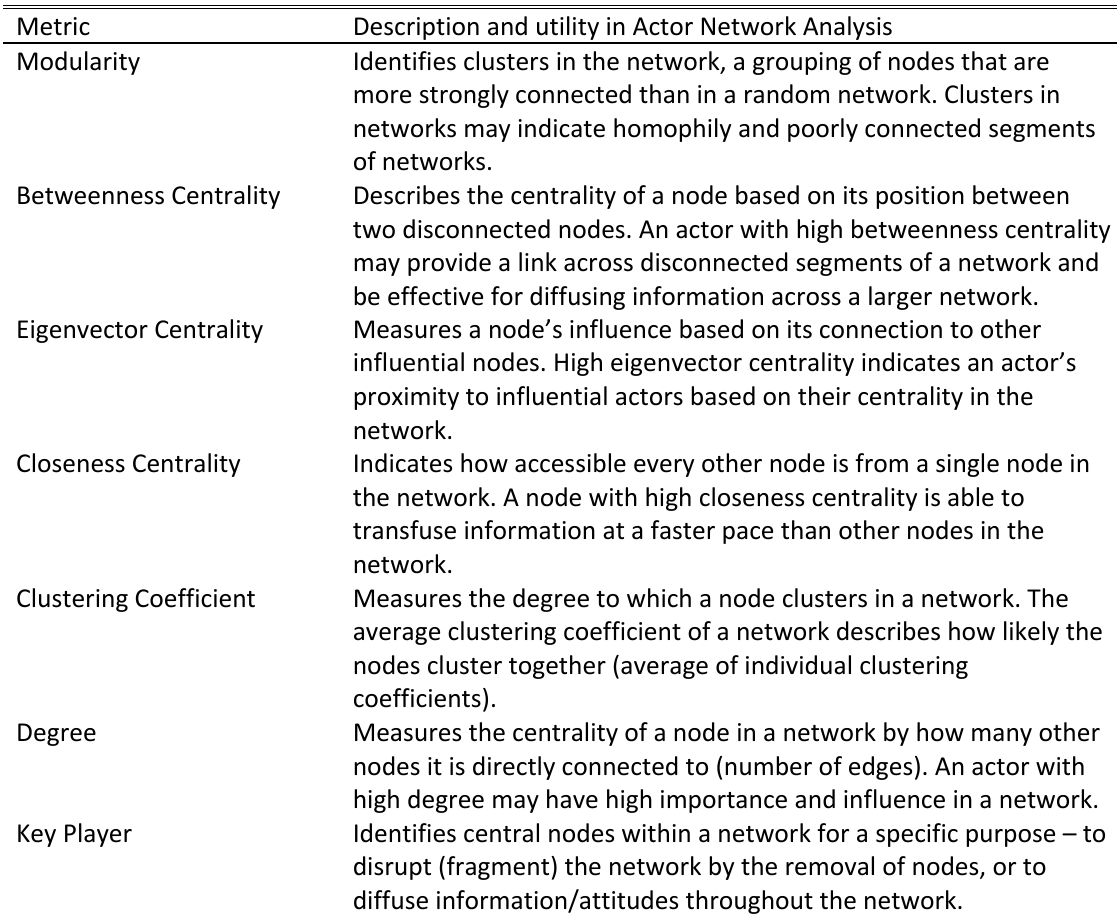
Table A1.1 Description of key network concepts and statistical metrics used in the analysis